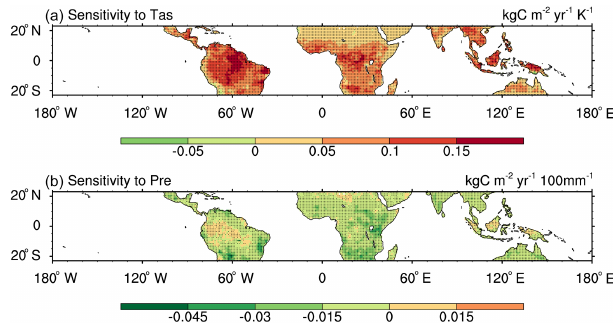
Figure 9. Spatial sensitivities of the ensemble mean in tropical CF TA interannual anomalies to tropical near-surface air temperature (kgCm − 2 yr − 1 K − 1 ) and precipitation (kgCm − 2 yr − 1 100mm − 1 ) over land. The dotted areas in both figures indicate correlation above 95% significance ( p ≤ 0 .